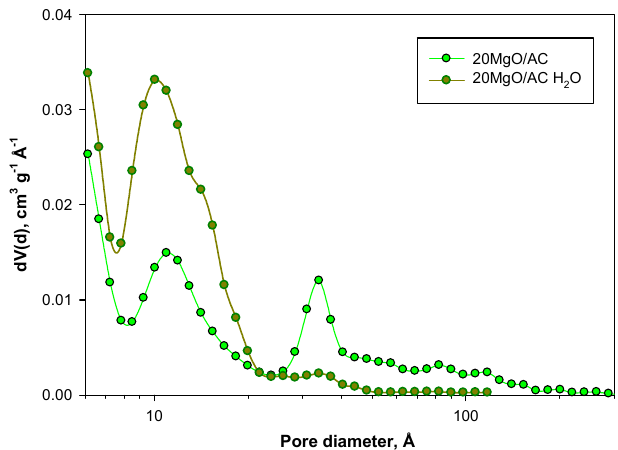
Figure 7. Effect of the exposure to wet reaction conditions at 400 °C for a total of 9 h on the PSD of a fresh 20% MgO/AC catalyst.